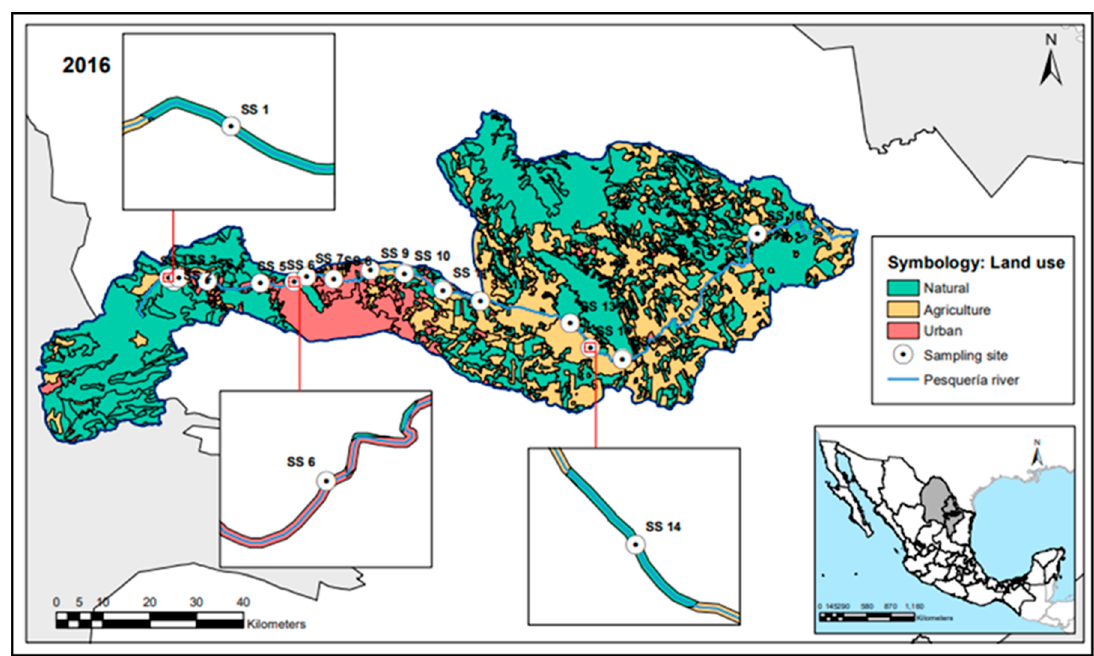
Figure 1. Illustration of the riparian buffer preparation.